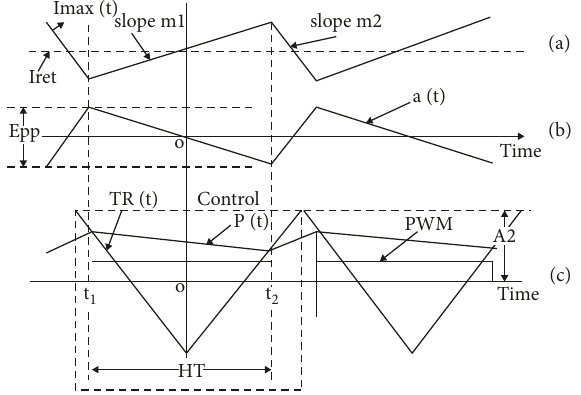
Figure 3: Generalized graphical representation of (a)